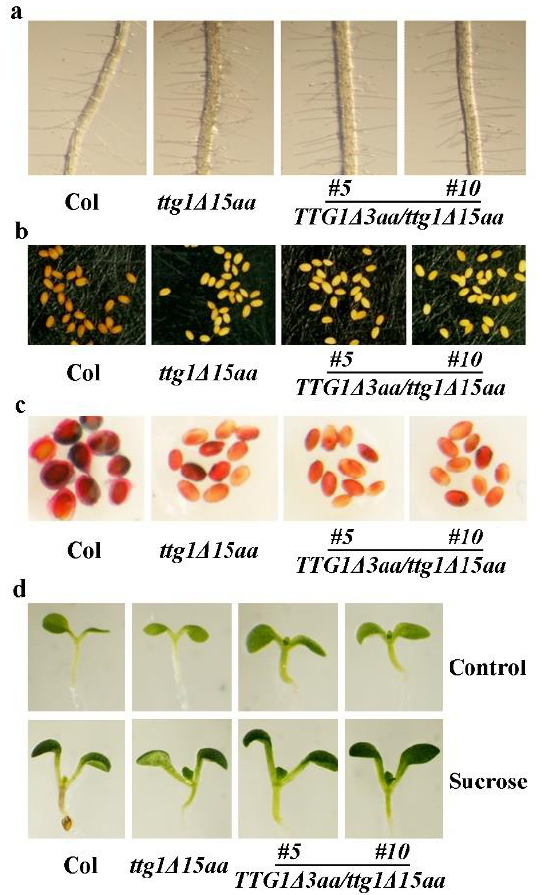
Root hair formation assays show that the TTG1 ∆ 3aa/ttg1 ∆ 15aa transgenic plant seedlings still produced more root hairs (Figure 9a), and a quantitative analysis indicates that the root hair density in the transgenic plant seedlings is similar to that in the ttg1 ∆ 15aa mu- tant seedlings (Figure 4b). Furthermore, the TTG1 ∆ 3aa/ttg1 ∆ 15aa transgenic plants still produced yellow-colored seeds, as observed in the ttg1 ∆ 15aa mutant (Figure 9b). The ruthe- nium red staining results show that the seed coats of the TTG1 ∆ 3aa/ttg1 ∆ 15aa transgenic plants are still not able to produce mucilage (Figure 9c), and the sucrose treatment suggests that the anthocyanin phenotypes observed in the ttg1 ∆ 15aa mutant are also not restored in the TTG1 ∆ 3aa/ttg1 ∆ 15aa transgenic plants (Figure 9d).